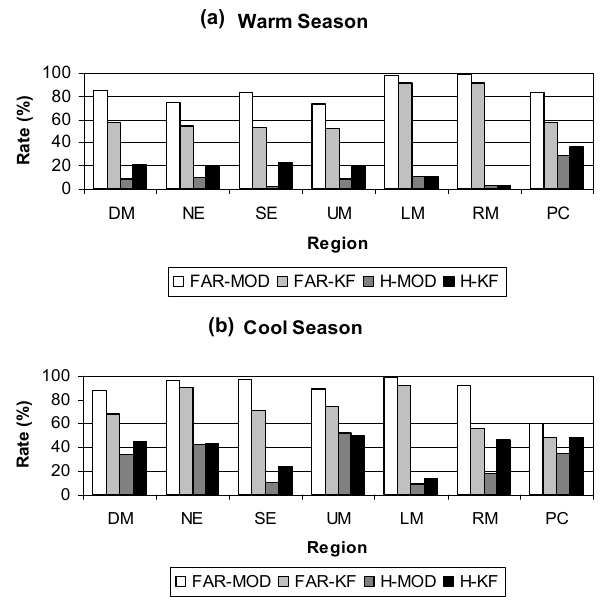
Fig. 12. False alarm ratio (FAR) and hit rate (H) for the daily mean PM 2 . 5 forecasts by the raw model and the KF bias-adjustment over the domain (DM) and all the sub-regions during (a) warm season and (b) cool season: FAR-MD, FAR associated with raw model forecasts; FAR-KF, FAR associated with KF forecasts; H-MD, H associated with raw model forecasts; and H-KF, H associated with KF